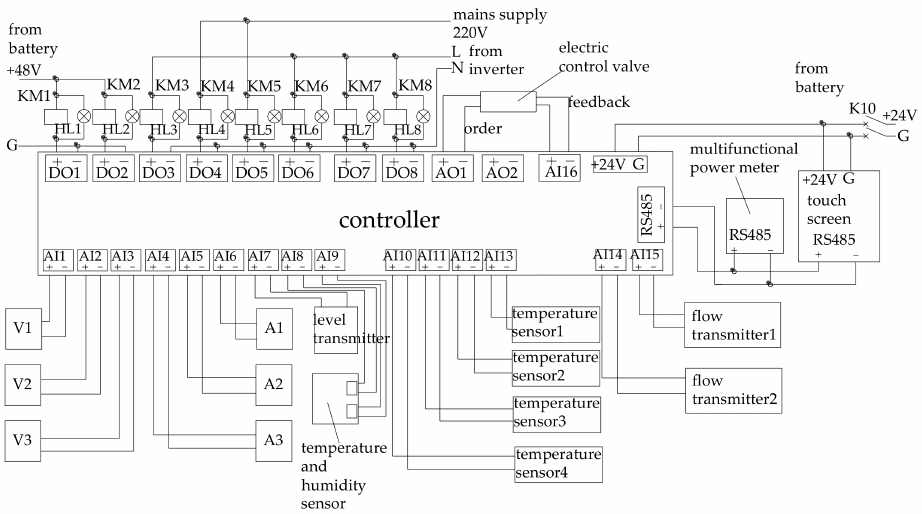
Figure 2. Schematic diagram of electrical control 1.